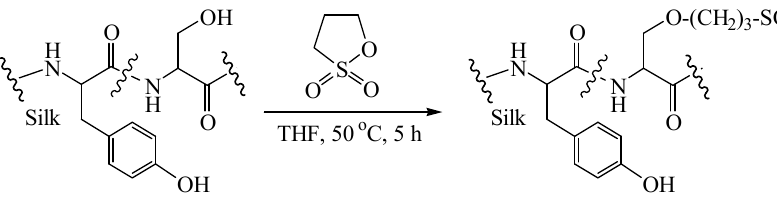
Figure 1. Modification of SF through serine amino acid residues using 1,3-propane sultone.